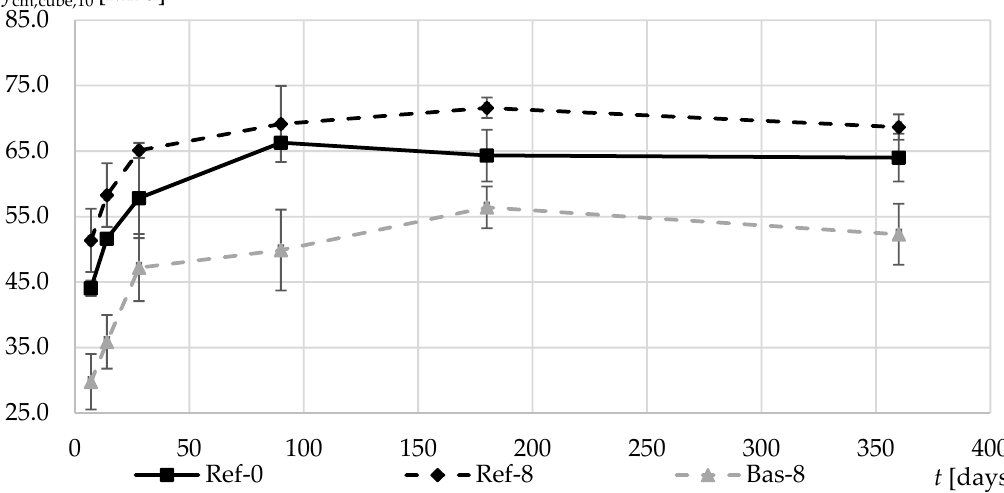
Figure 9. Average compressive strength in the first 360 days of composites curing.